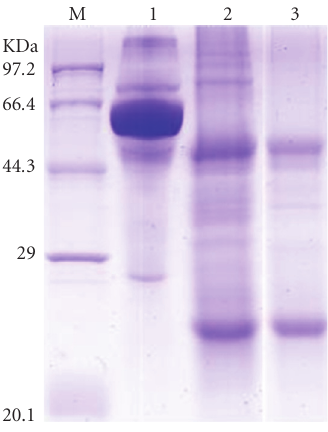
Figure 3: SDS-PAGE analysis of the polyclonal antibody. M: molecular weight marker; 1: serum without purification; 2: serum purified with SAS; 3: polyclonal antibody after purification by a ffi nity chromatography.